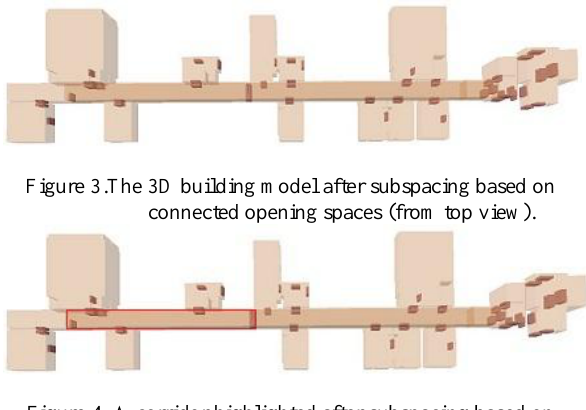
Figure 4. A corridor highlighted after subspacing based on connected opening spaces.